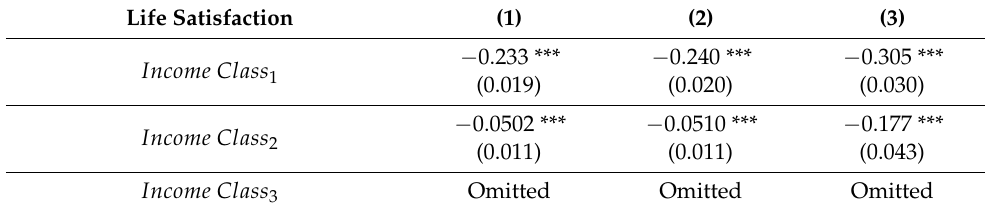
Table 4. Robustness analysis: one-way fixed effects